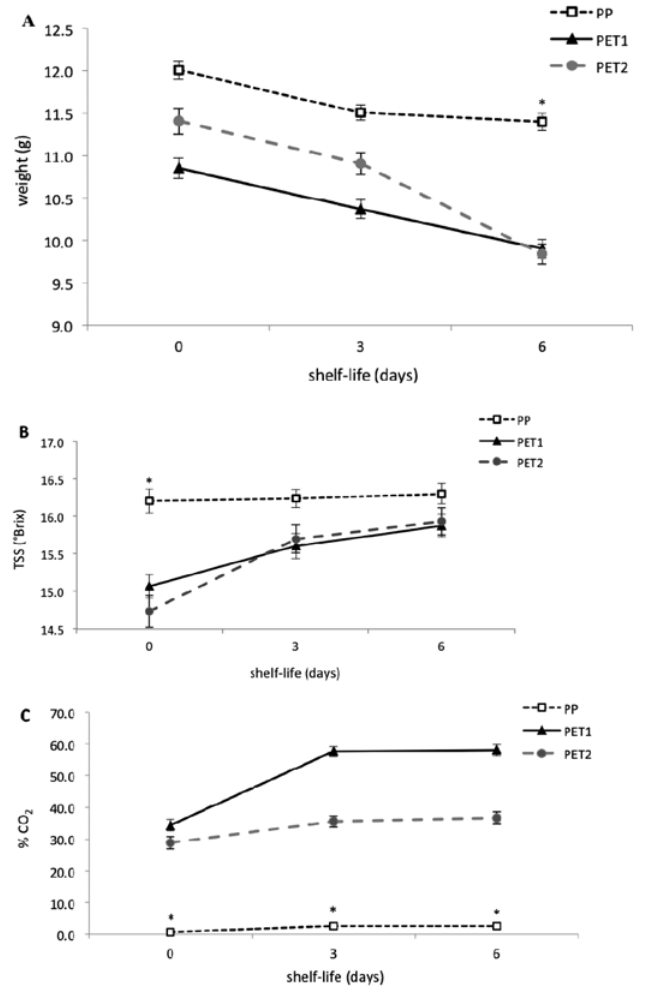
Fig. 2 - Changes in weight loss (A), soluble solid content (B) and head- concentration (C) of minimally processed ‘Vittoria’ space CO 2 grape berries during shelf life after 14 days of cold storage (5°C): microperforated polypropylene packaging in air (PP); non-microperforated polyethylene packaging in 20% CO (PET1); non-microperforated polyethylene packaging in 5% O +15% CO +N (PET2). Data are mean±SE. * indicate signifi- 2 2 cant differences for values